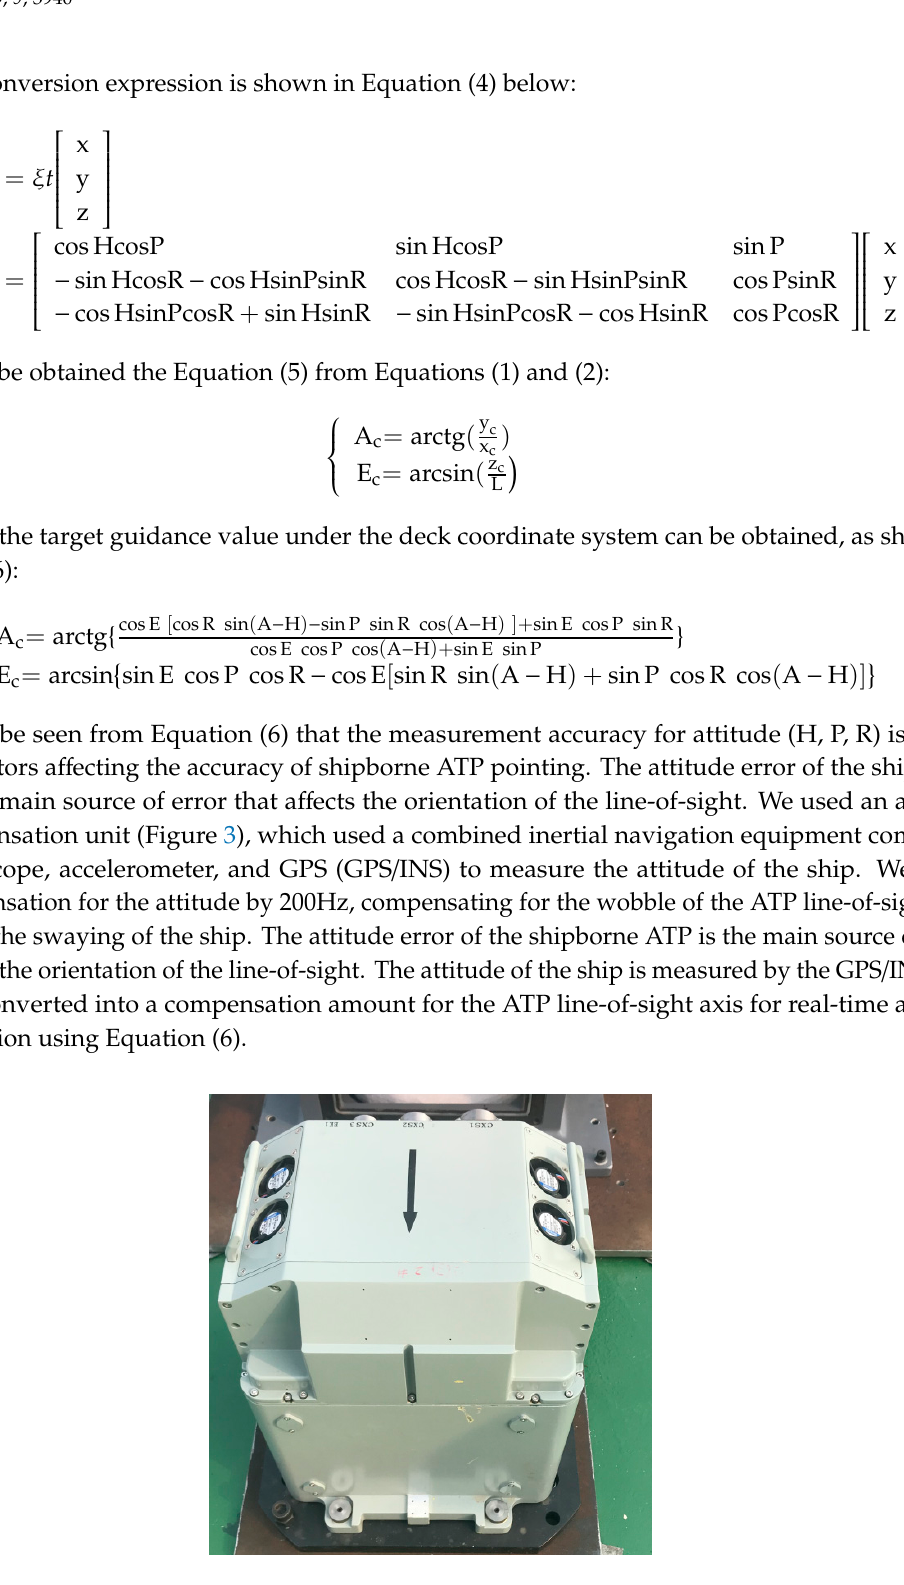
Figure 3. Attitude pre-compensation unit.